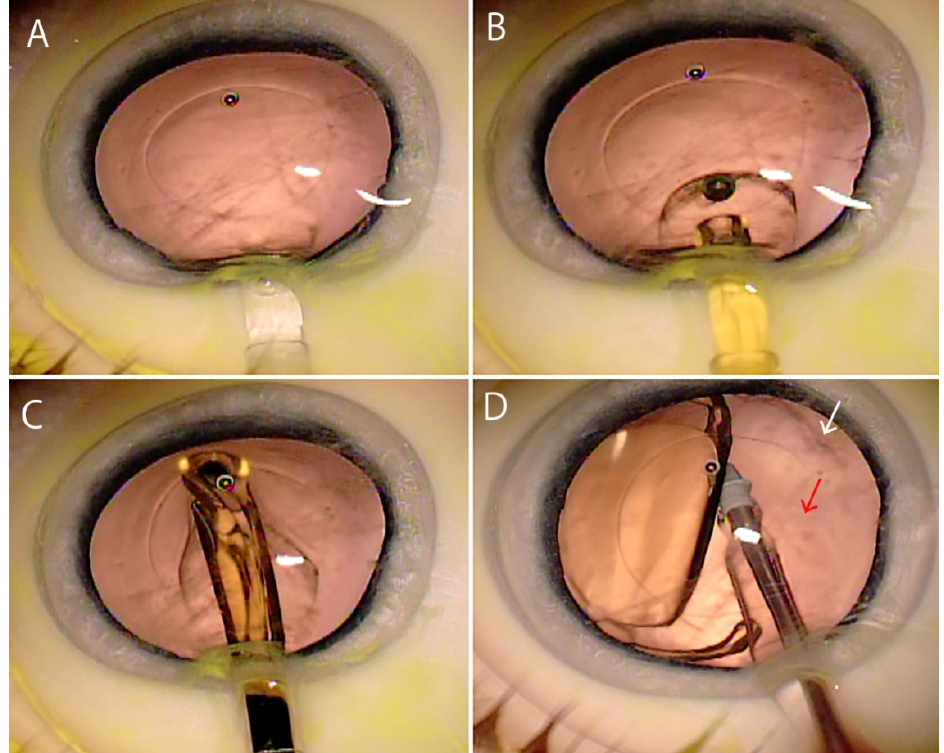
Figure 3. Application of fluoresbrite carboxylate microspheres (1 µm) onto the ocular surface of porcine eye with eyelids. ( A ) Accompanying insertion of the intraocular lens, ( B ) the fluoresbrite microspheres are introduced into the anterior chamber in the shape of balloon due to displacement by the ophthalmic viscosurgical device. ( C ) The fluoresbrite microspheres spread around the intraocular lens. ( D ) Even after washing the anterior and posterior surfaces of the intraocular lens, the fluoresbrite microspheres remain in the anterior chamber (white arrow) and a small amount of fluoresbrite microspheres enter the vitreous body (red arrow). (Authors’ unpublished images).